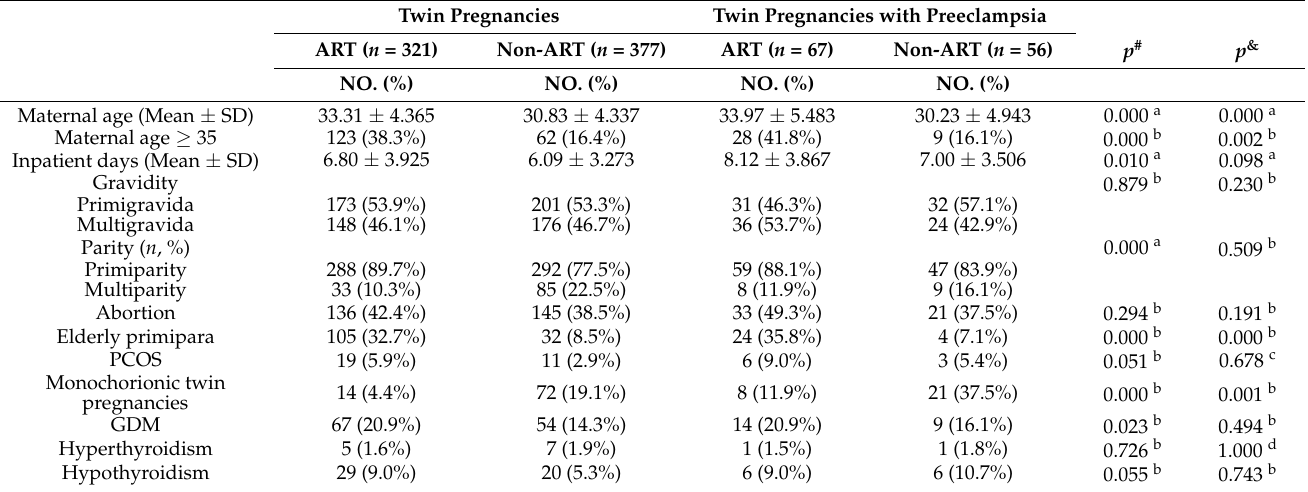
Figure 2. Hypertension disorders in ART and non-ART group. * p < 0.05 was considered significant. Table 3. Clinical characteristics of twin pregnancies with preeclampsia and their association with